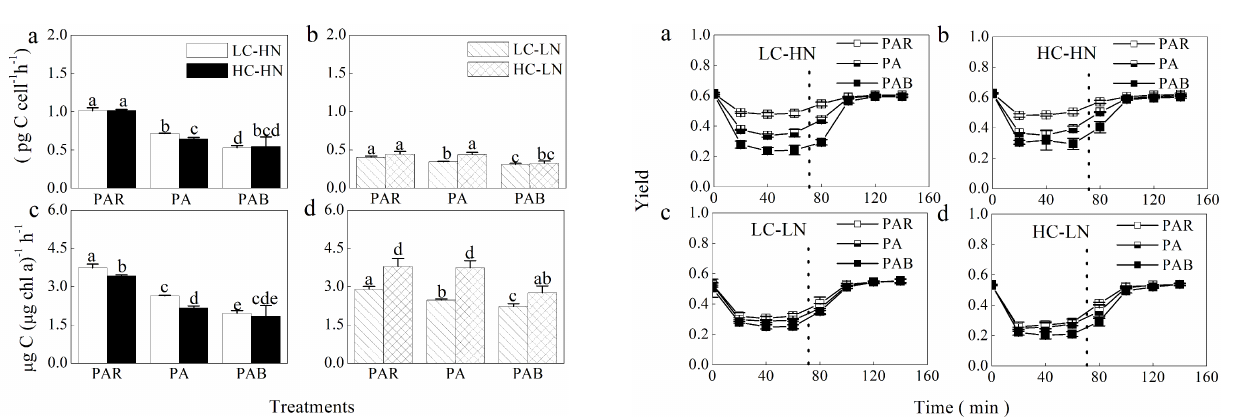
Figure 1. Photosynthetic carbon fixation rates of P. tricornutum Figure 2. The effective quantum yield of P. tricornutum under dif- under different treatments. Photosynthetic carbon fixation rates of ferent treatments. Changes of effective quantum yield in P. tricor- P. tricornutum cells represented as rates (a, b) per cell and (c, nutum cells at ambient (390µatm, LC) or elevated CO 2 (1000µatm, d) per Chl a grown at ambient (390µatm, LC) or elevated CO 2 HC) under (a, b) NO − -replete (110µmolL − 1 , HN) and (c, d) 3 (1000µatm, HC) under NO − -replete (110µmolL − 1 , HN) (a, c) NO − -limited (10µmol L − 1 , LN) conditions when exposed to PAR, 3 3 or NO − -limited conditions (10µmolL − 1 , LN); (b, d) when ex- PAR + UVA (PA) and PAR + UVA + UVB (PAB) for 60min and 3 posed to PAR, PAR + UVA (PA) and PAR + UVA + UVB (PAB) another 80min under the growth light level (the time of the switch for 60min, respectively. Vertical bars indicate ± SD; the means and to growth light levels is indicated by the dashed line), respectively. standard deviations were based on three replicates. The different The irradiance intensities under solar simulator or growth light were lowercase letters indicate significant differences between different the same as mentioned above. Vertical bars show mean ± SD, n = treatments at P< 0 . 05 level.